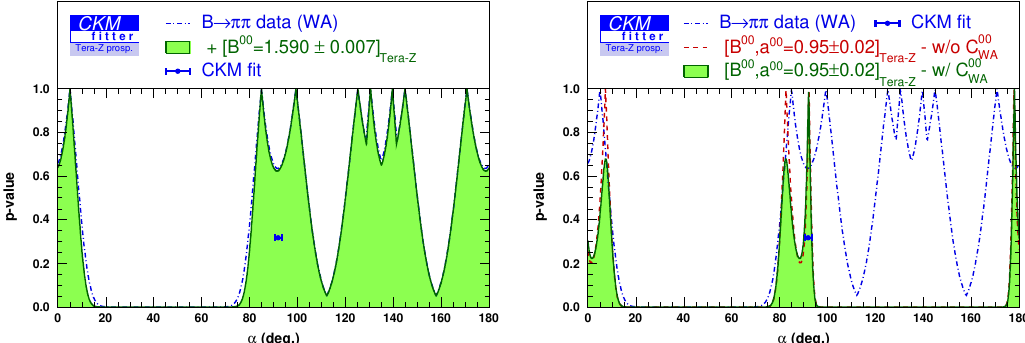
Figure 14 . p -value for α from B → ππ measurements. On the left: using the current data (dotted-dashed blue) and the improved measurement of B ( B → π 0 π 0 ) alone. On the right: using the current data (dotted-dashed blue), the improved measurements of B → π 0 π 0 observables but without the current measurement of C 00 (dashed red) and with this measurement (solid green, CP scenario 1). We take the baseline value a 00 = 0 . 950 ± 0 . 018 CP